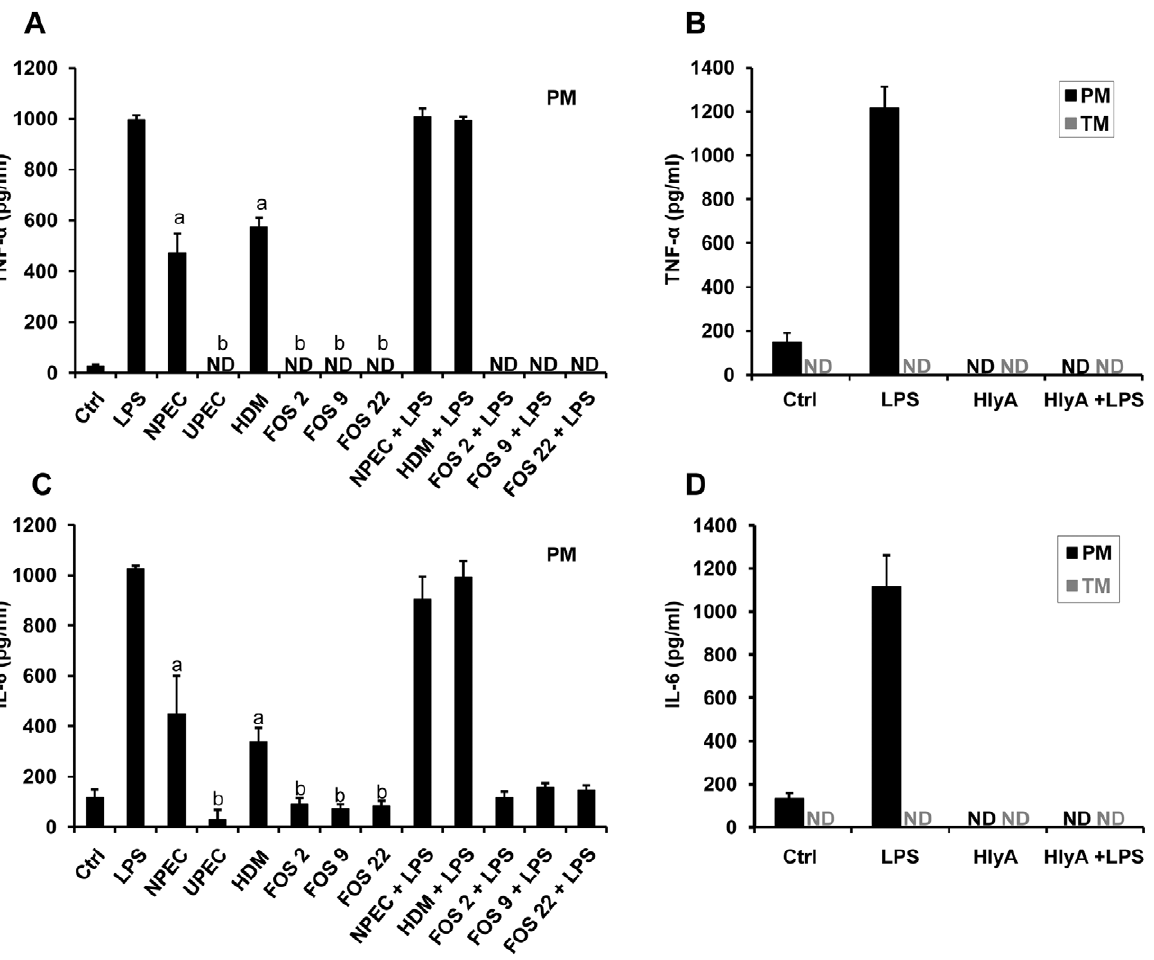
Figure 4. UPEC virulence factor hemolysin inhibits pro-inflammatory cytokine secretion. ( A, C ) PM were infected with NPEC mutants expressing hemolysin (FOS 2, FOS 9 and FOS 22), UPEC 536 hemolysin double mutant and wild type NPEC EPI-T1 R strain for 5 h with or without concomitant LPS stimulation. ( B, D ) PM and TM were treated with 20 ng/ml hemolysin in the presence of LPS or without for 5 h. IL-6 and TNF- a concentrations in culture supernatants were measured by sandwich ELISA. Values are means 6 SD of triplicates. MOI=0.1. Tukey-Kramer multiple comparisons test was used to analyze significance of data. Values with different letters superscript differ significantly (p , 0.001) compared to NPEC and HDM. ND=not